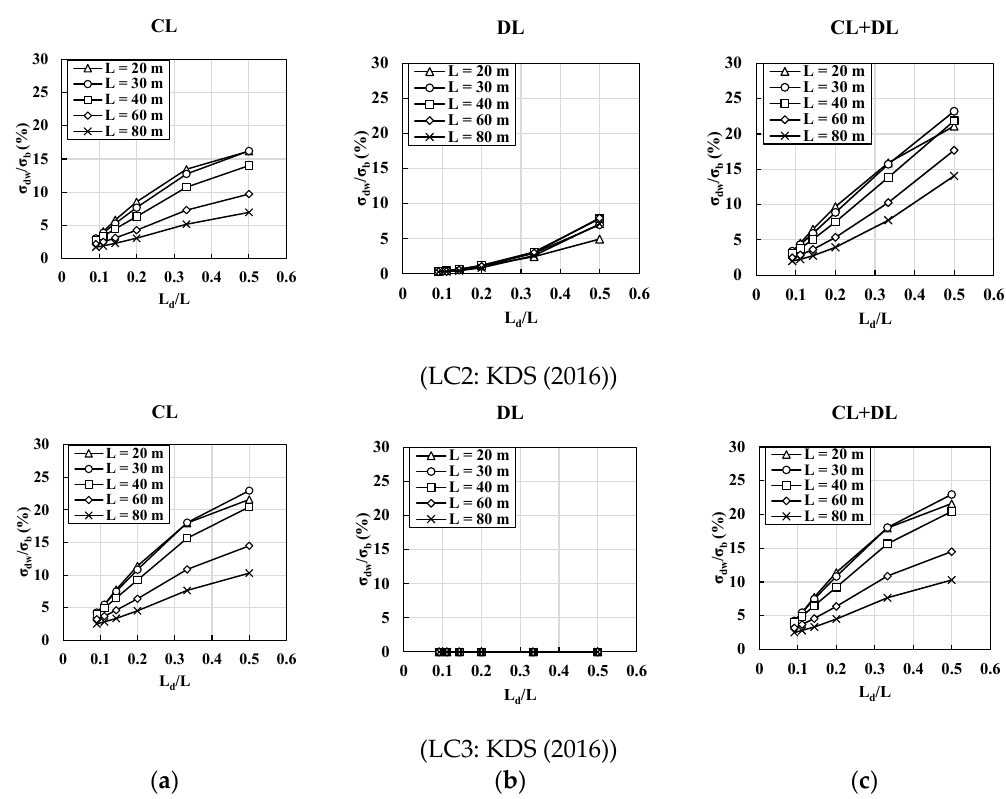
Figure 12. Variations in distortional warping normal stresses at H / B = 0.7 with the design load components. ( a ) Concentrated loads, ( b ) distributed loads, and ( c ) combined concentrated and distributed loads.